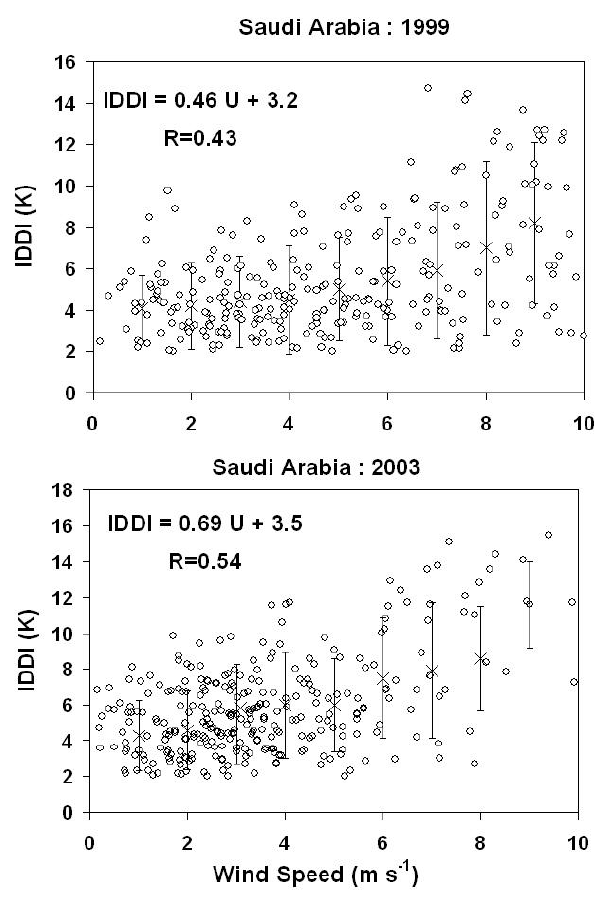
Fig. 7. Scatter plot of daily IDDI versus wind speed for Saudi Arabia-I. The Points with vertical bar represent bin average and vertical bar represent standard deviation. The solid line represents linear least-squares fit to the data points.